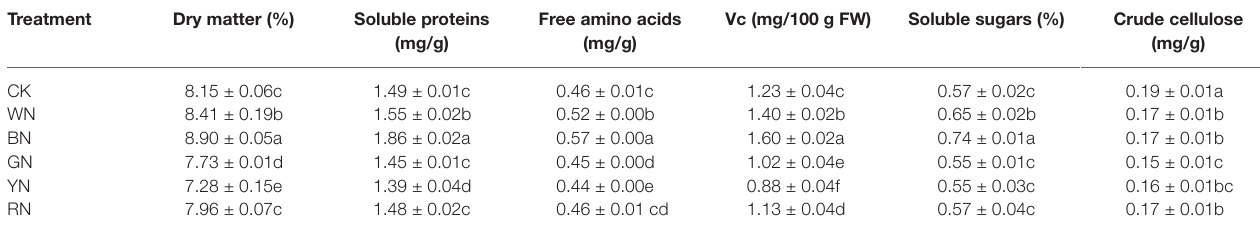
TABLE 4 | Effect of photo-selective nets on the quality of green onion. Treatment